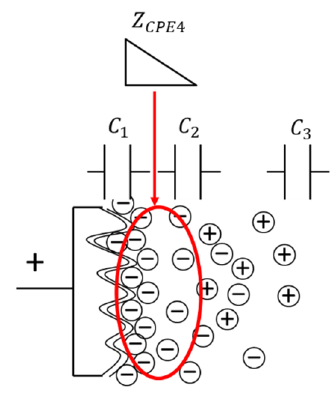
Figure 7. Internal model of the cathode side of a degraded EDLC.